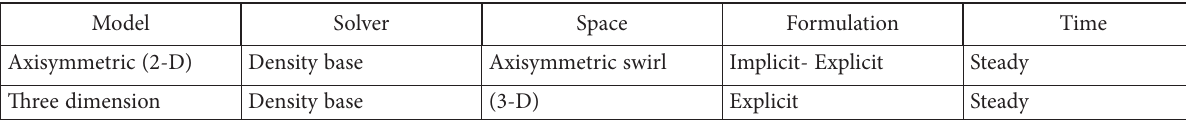
Table 1. General details of the models in the software